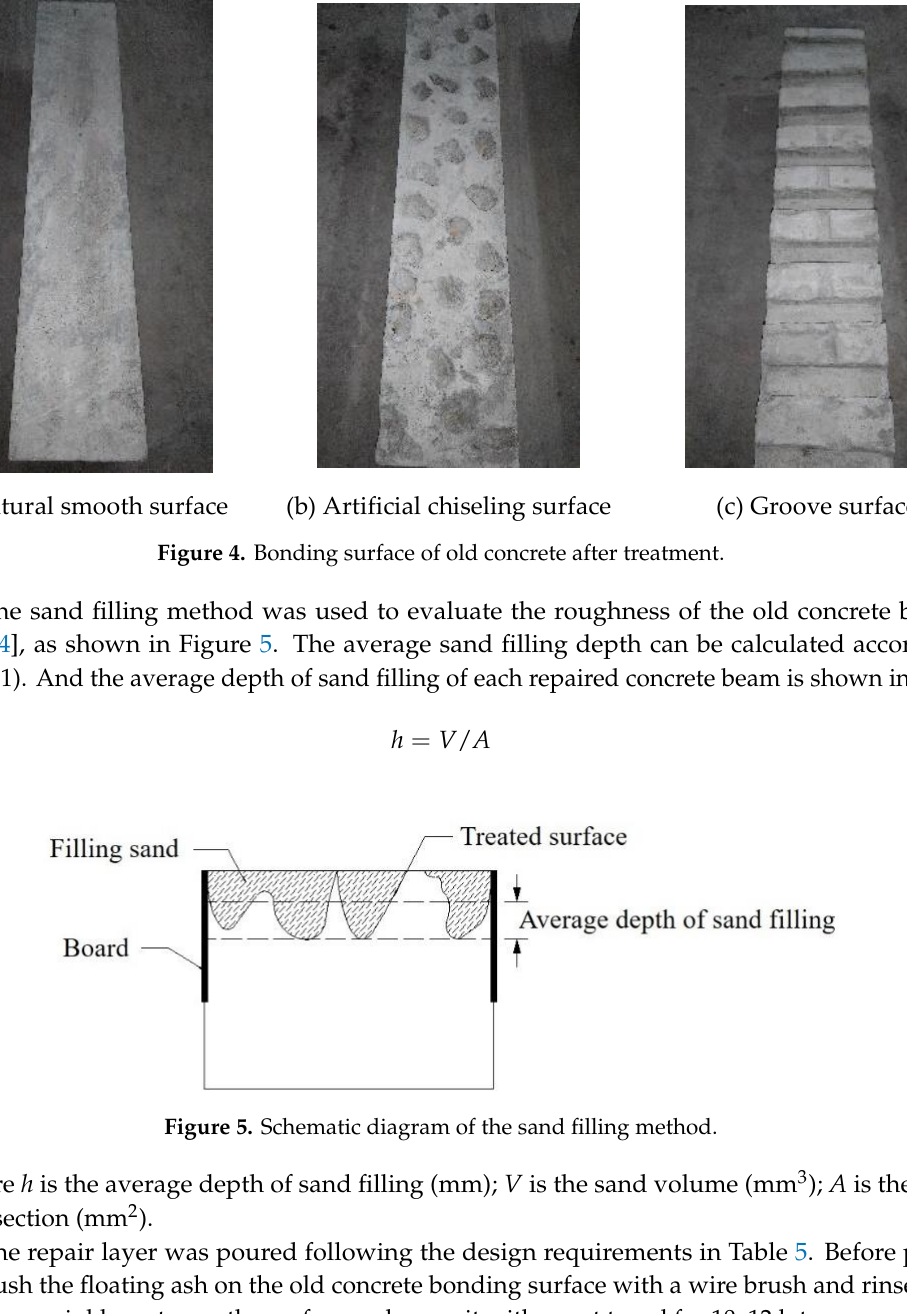
Figure 5. Schematic diagram of the sand filling method.